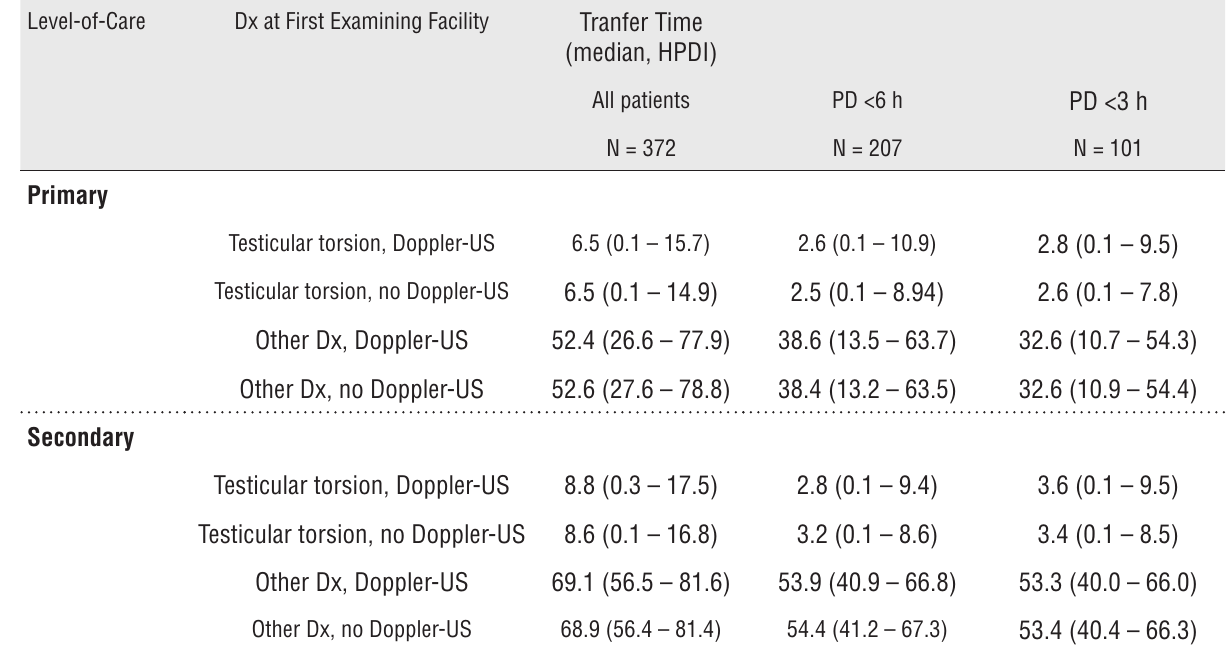
Table 2 - Bayesian linear regression model output. Level-of-Care